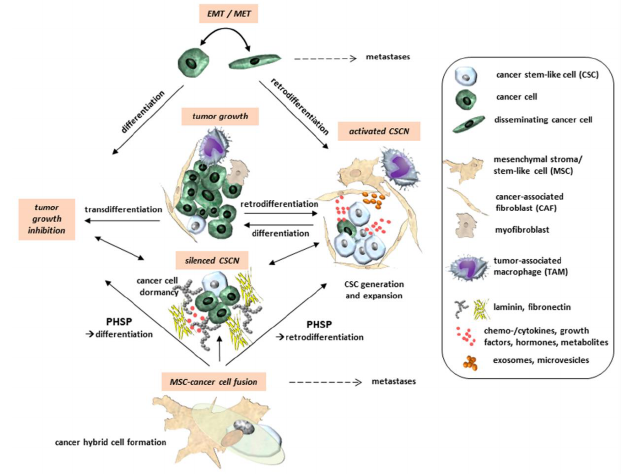
Figure 1. Tumor plasticity comprises several genetic and epigenetic programs including epithelial-mesenchymal transition (EMT)/ mesenchymal-epithelial transition (MET) or cancer cell fusion. These contribute to the enrichment of cancer cell progenitors or cancer stem cells (CSC) populations within an activated CSCN (cancer stem cell niche) for CSC expansion or a silenced CSCN for maintenance of dormant CSCs. The multiple underlying programs such as differentiation, trans- or retrodifferentiation, metastases formation, or PHSP (post-hybrid selection process) may take place simultaneously in distinct compartments of the tumor tissue (adapted from [18,26]).